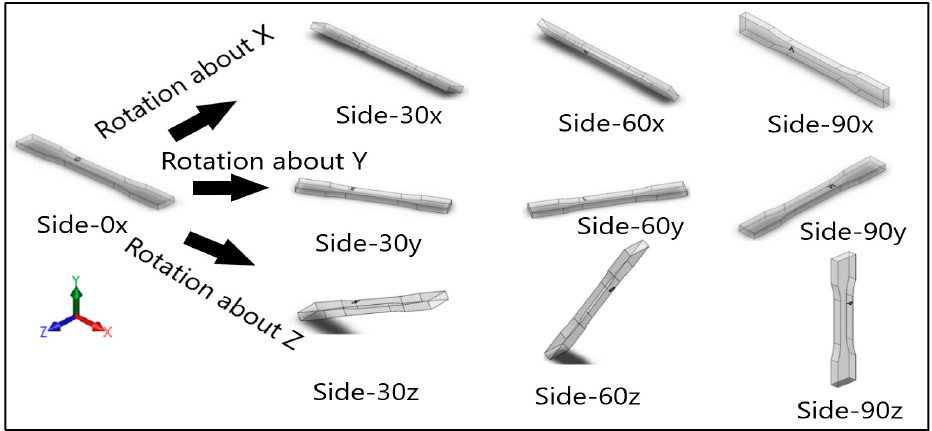
Figure 4. Isometric view of side-built samples, 0°, 30°, 60°, and 90° from left to right for each axis rotation (separate rows for x, y, and z-axis), respectively.